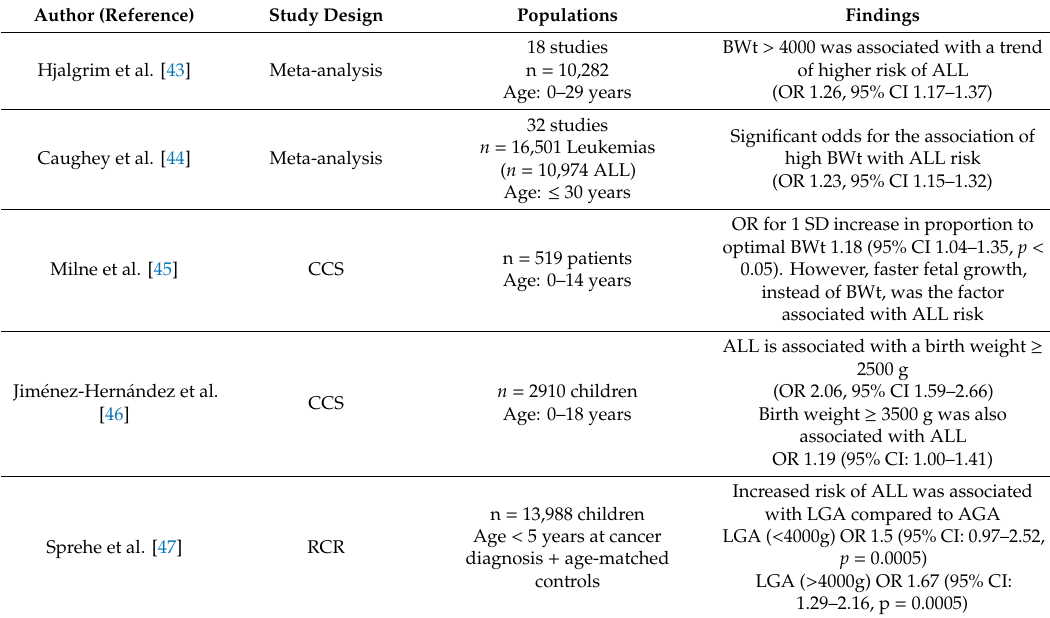
Table 2. Birth Weight and the Risk of Development of